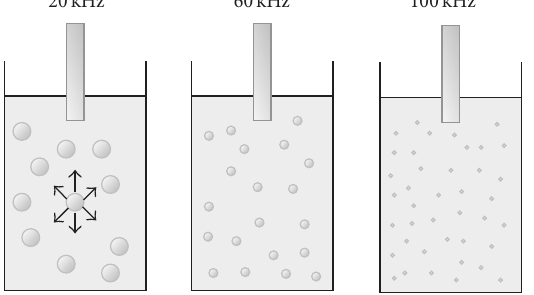
Figure 3: Influence of frequency on the number and diameter of cavitation bubbles